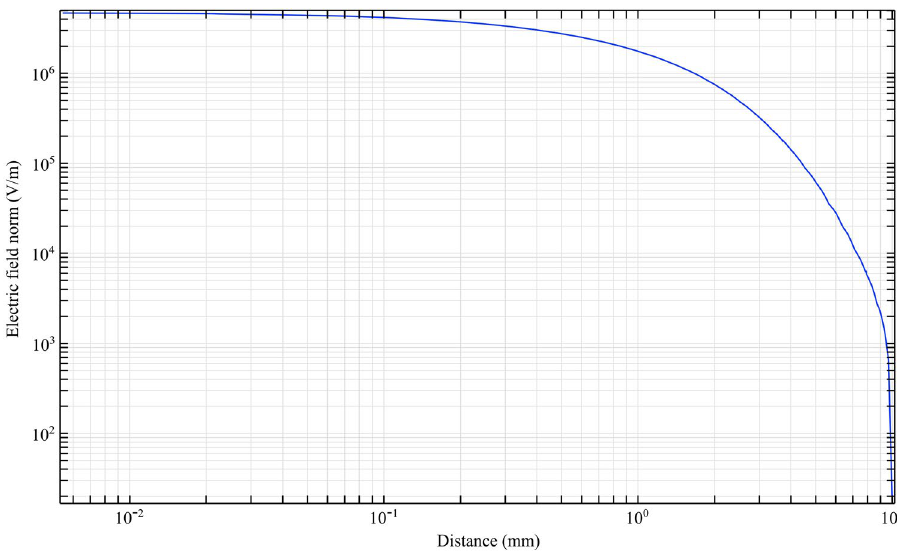
Figure 10. Simulation of electric field from tip electrode to end of plasma jet nozzle based on nozzle Fig. 9a.